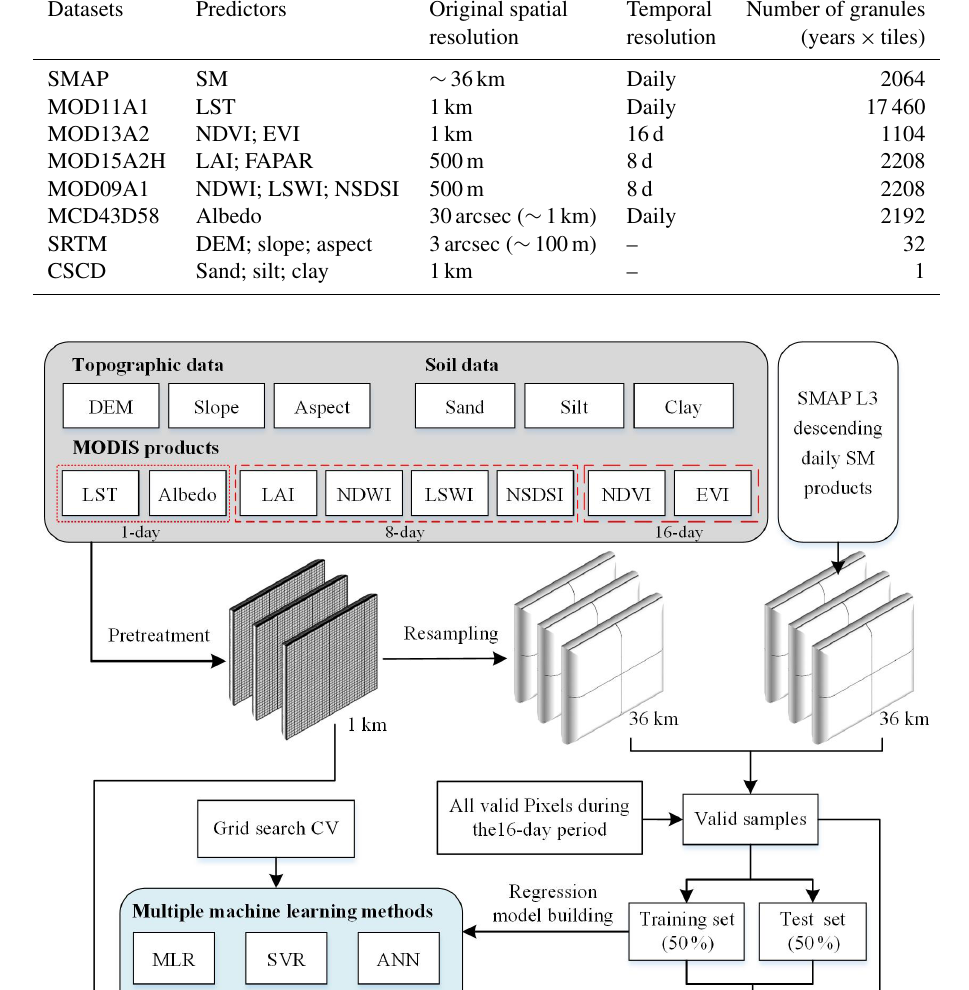
including LST, albedo, LAI, NDWI, LSWI, NSDSI, NDVI, EVI, DEM, slope, aspect, sand, silt and clay, were aggregated into a resolution of 1 km with a GeoTIFF format. These vari- ables were further resampled to the spatial resolution of the SMAP SM data (36 km) using the nearest-neighbor interpo- lation